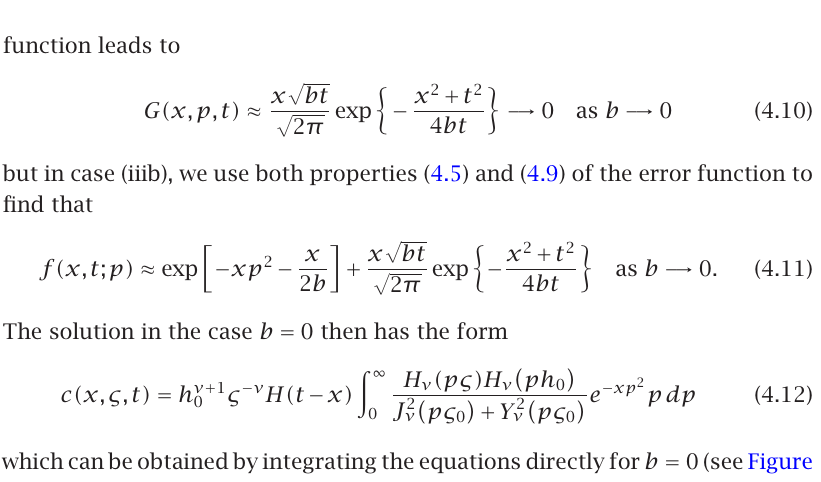
Figure 4.1 . The isolines of the concentration of the point source in the (x,z) plane when h = 5 . 0, ν = 0 . 5, and z o = 0 . 5 for (a) t = 1 . 5, (b) t = 5 . 0, (c) t = 9 . 0, and (d) t = 50 . 0, in the case when there is no horizontal